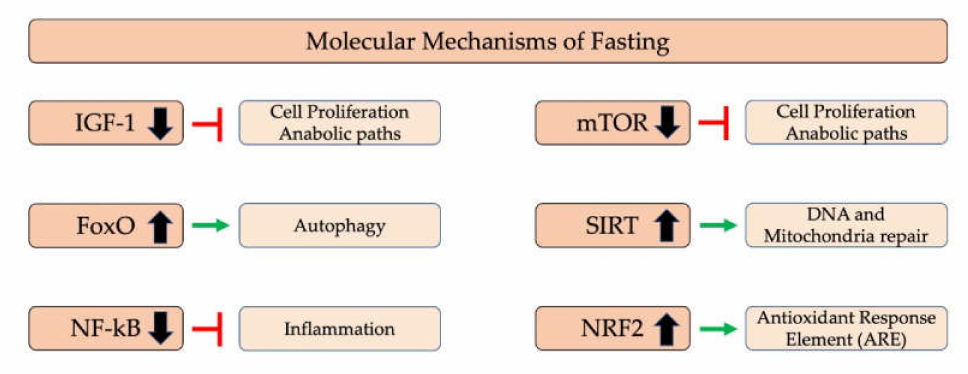
Figure 2. Molecular mechanisms of fasting. IGF-1, insulin-like growth factor 1; FoxO, forkhead box Proteins; NF-K β , nuclear factor-K β ; mTOR, mammalian target of rapamycin; SIRT, sirtuins; NRF2, nuclear factor erythroid 2-related factor